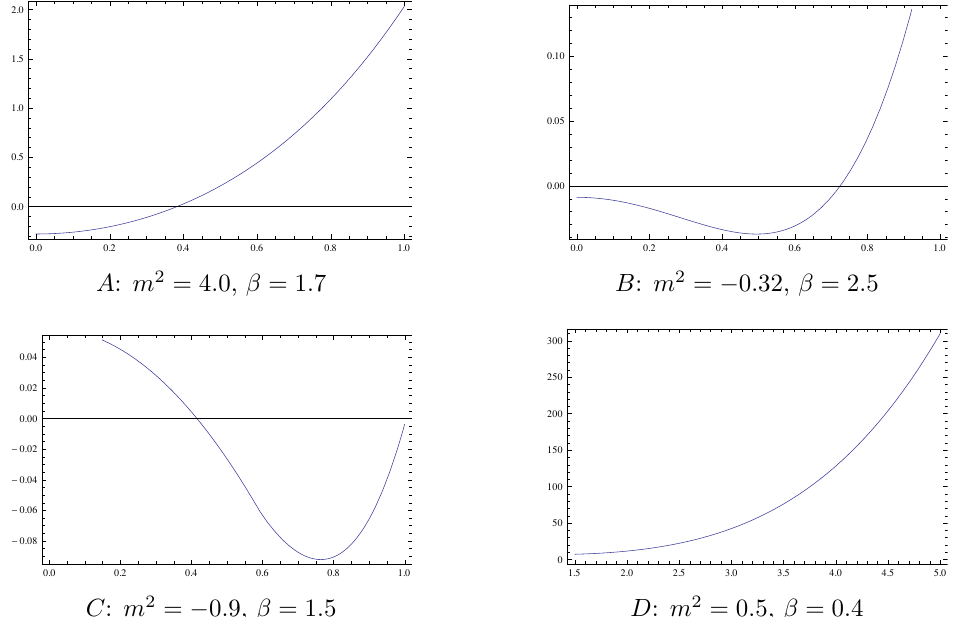
Figure 6. Representative plots of the potential corresponding to the regions in figure 5(a) for λ = 1 .